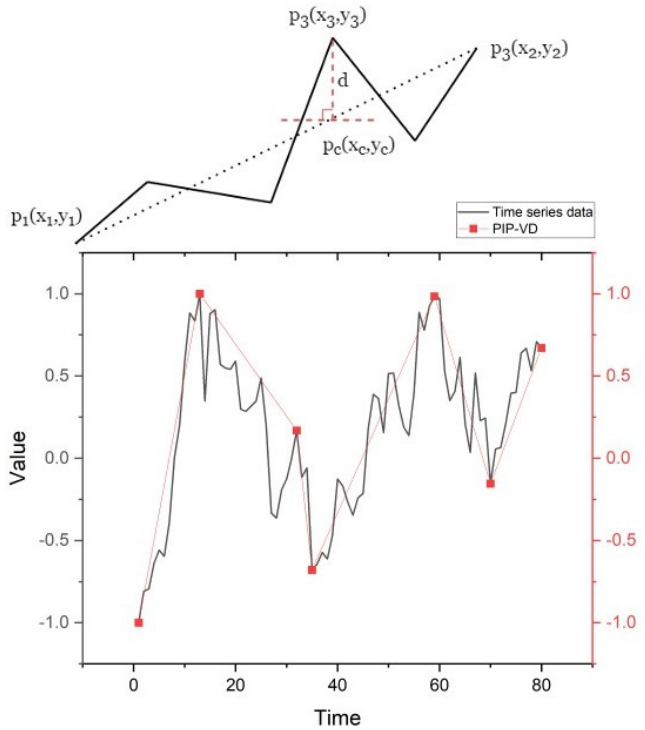
Figure 3. The above subgraph is the demonstration of the PIP-VD measure. A 80 days’ normalized time series data (black line) is represented by 7 extracted PIPs (red points) using PIP-VD. Algorithm 1 is the pseudocode for the selection procedure of the